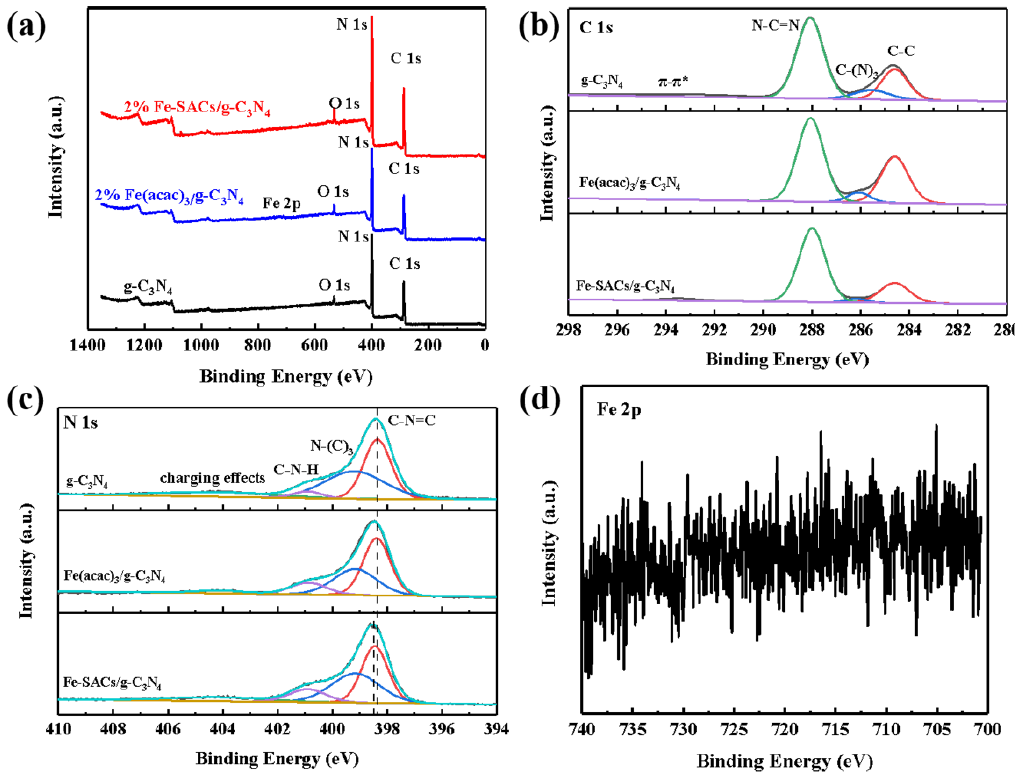
Figure 3. Full XPS spectra of g-C 3 N 4 , Fe(acac) 3 /g-C 3 N 4 , and 2% Fe-SACs/g-C 3 N 4 ( a ); and high-resolution XPS spectra of 2% Fe-SACs/g-C 3 N 4 C 1s ( b ), N 1s ( c ), and Fe 2p ( d ).